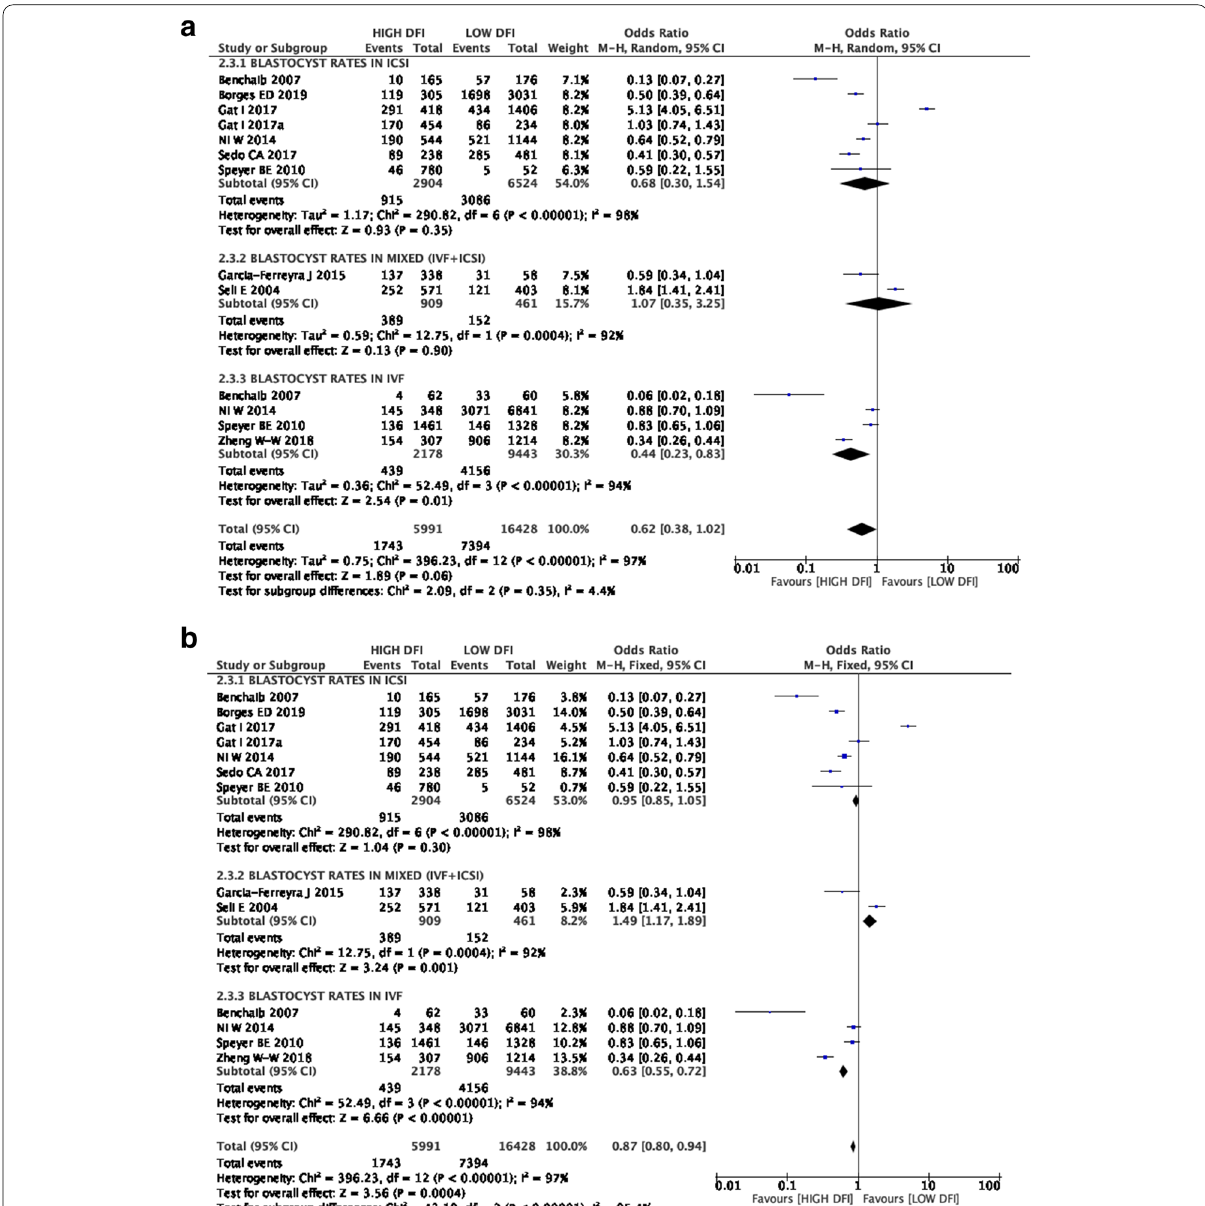
Fig. 4 a Comparison of blastulation rates in different ART methods (random). b Comparison of blastulation rates in different ART methods